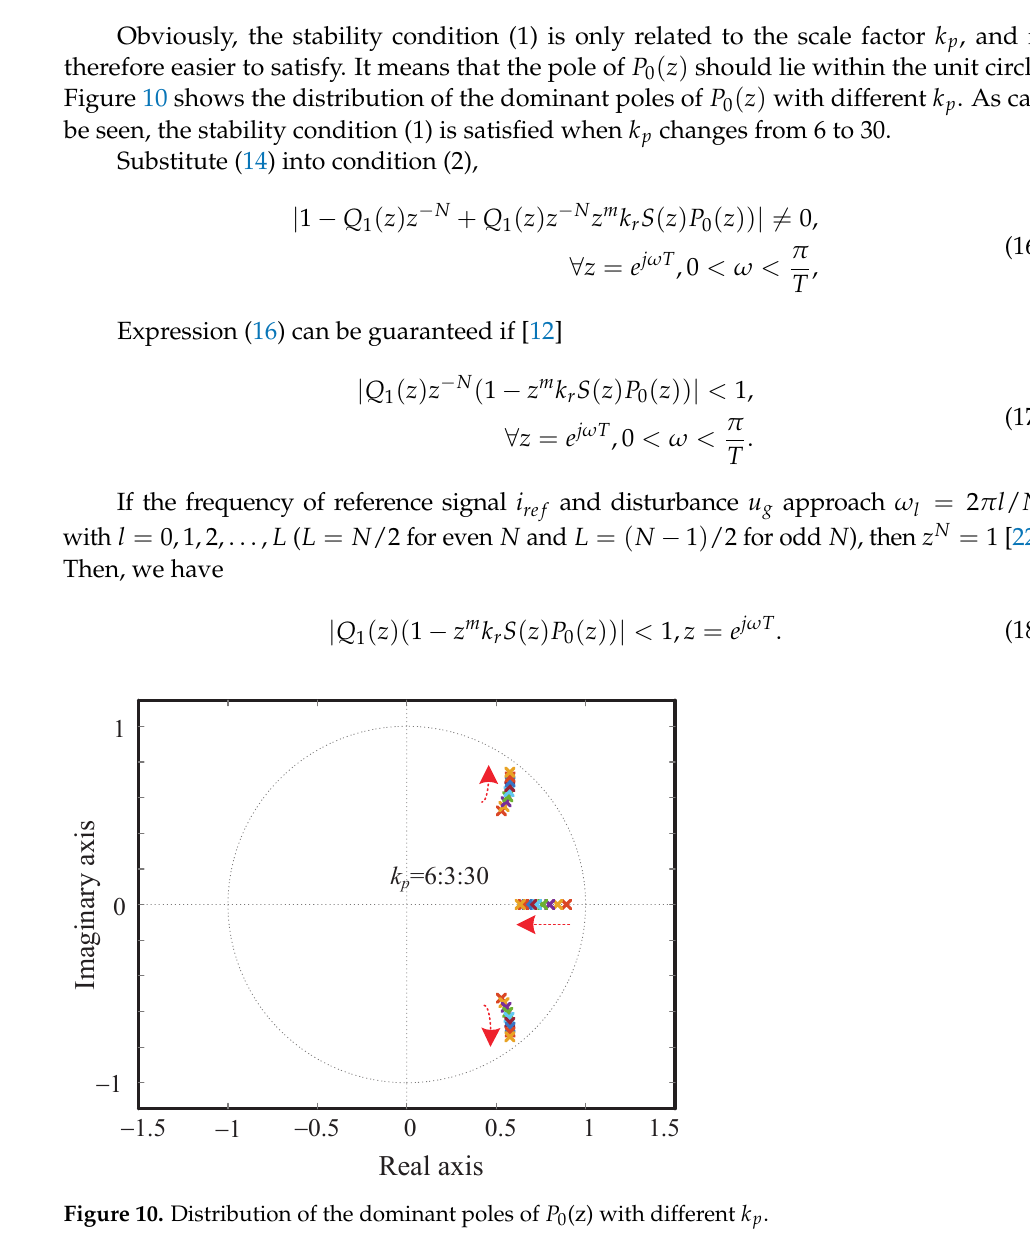
Figure 9. Block diagram of the FA-IRC system.